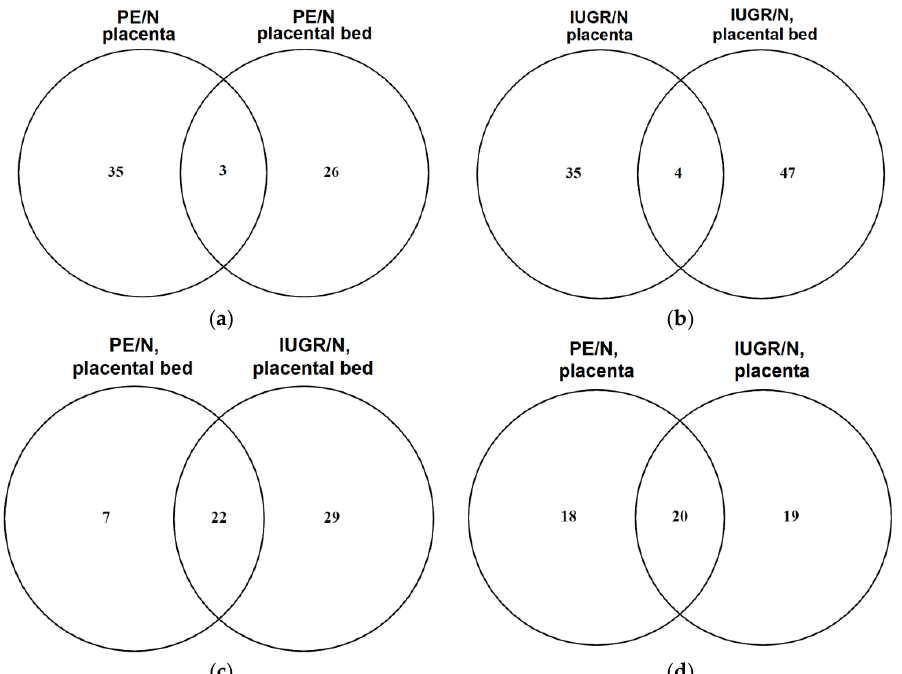
Figure 2. Venn diagrams. A comparison of the lists of differentially expressed proteins in ( a ) placenta vs. placental bed samples from patients with PE < 34; ( b ) placenta vs. placental bed samples from patients with IUGR < 34; ( c ) placental bed samples from patients with PE< 34 vs. IUGR < 34; ( d ) placenta samples from patients with PE < 34 vs. IUGR < 34.